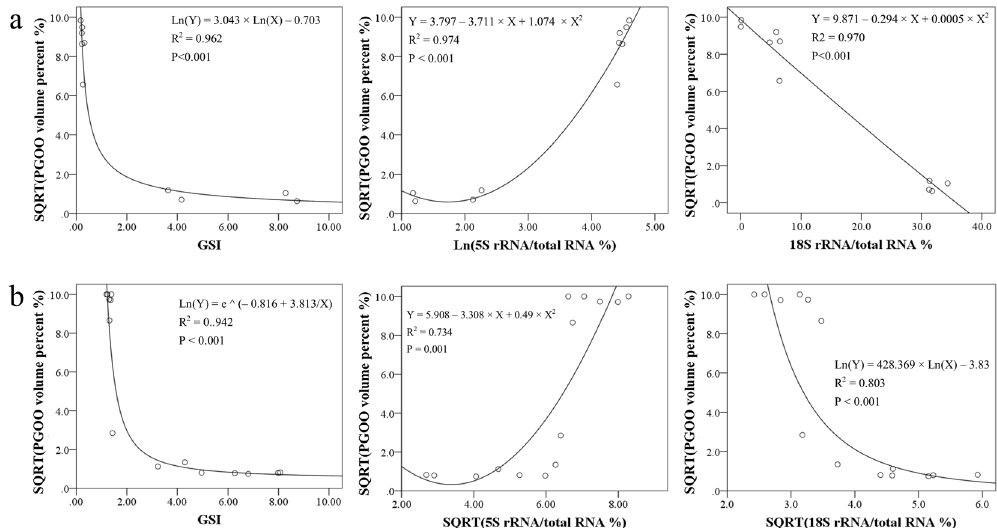
Figure 4. Regression between gonadosomatic index (GSI), 5S rRNA percent, or 18S rRNA percent and volume percent of primary growth stage oocytes relative to total volume of all oocytes. Ln, natural logarithm; e, natural constant; SQRT, square root. P, significance for formula estimation. Critical size points for primary growth oocytes are 184 and 174 µ m for yellow perch ( a , n = 10) and bluegill ( b , n = 14) respectively, according to species-specific measurement in histological images and criteria by McMillan 4 .